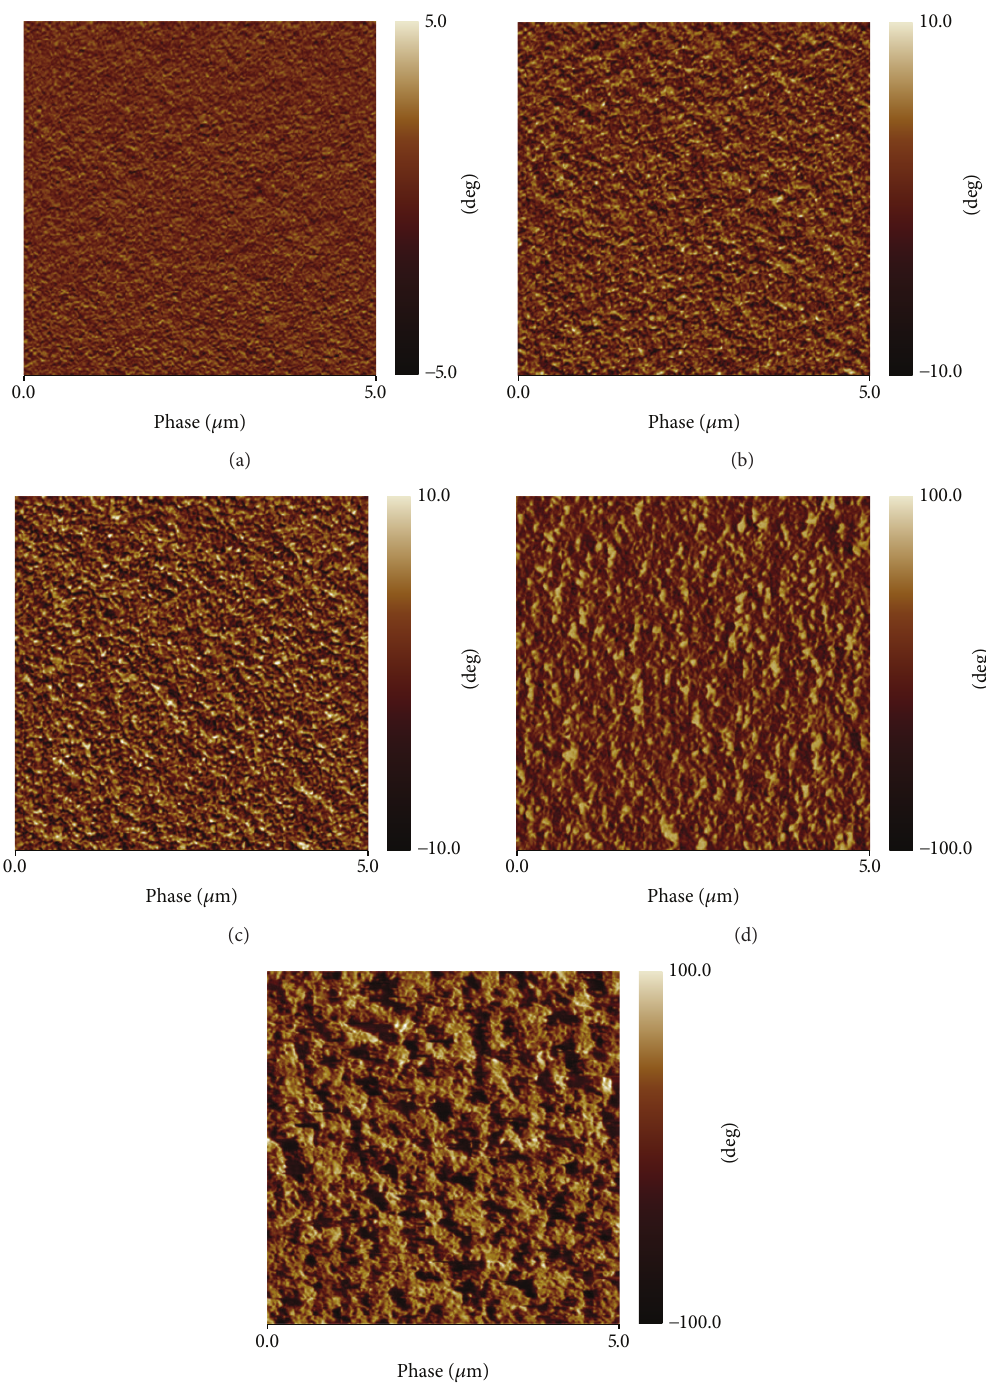
Figure 2: The AFM phase images of the PBDTTT-C:PC 71 BM films with 3% DIO heated under (a) room temperature, (b) 70 ∘ C, (c) 80 ∘ C, (d) 90 ∘ C, and (e) 100 ∘ C for 5